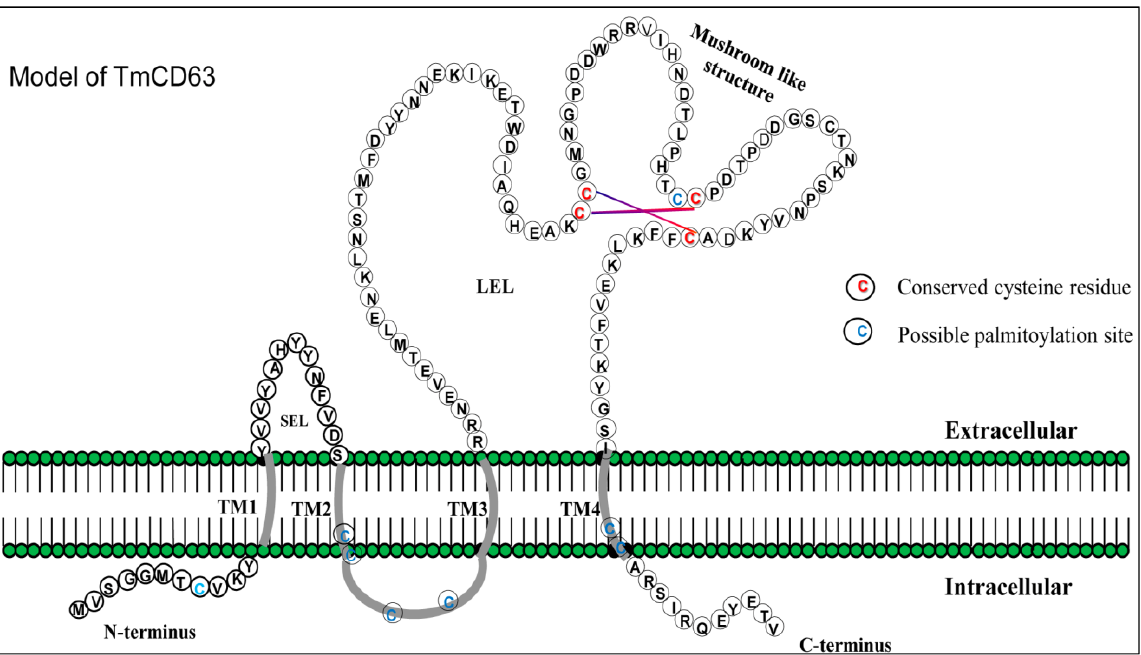
Figure 2. Schematic illustration of the structural design of TmCD63. The short extracellular loop (SEL), large extracellular loop (LEL) and the intracellular N - and C -terminal fragments are depicted with single-letter amino acid code. The transmembrane regions and the intracellular loop region are highlighted in grey. The possible juxtamembrane palmitoylated cysteines are indicated in blue. The conserved cysteines, which might form a functional mushroom architecture by disulphide bonds within the highly conserved “Cys-Cys-Gly” motif in the LEL, are indicated in red.